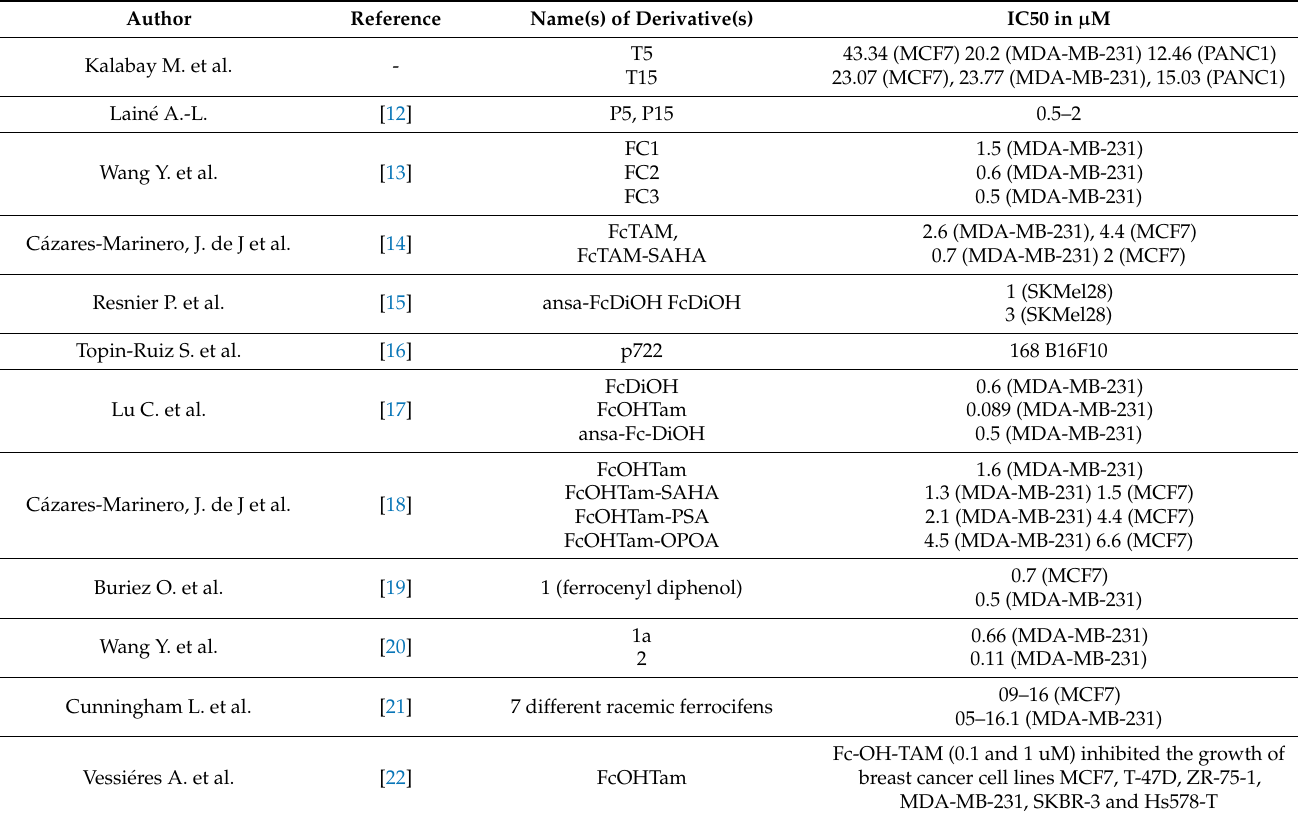
Table 1. Collection of different reports on